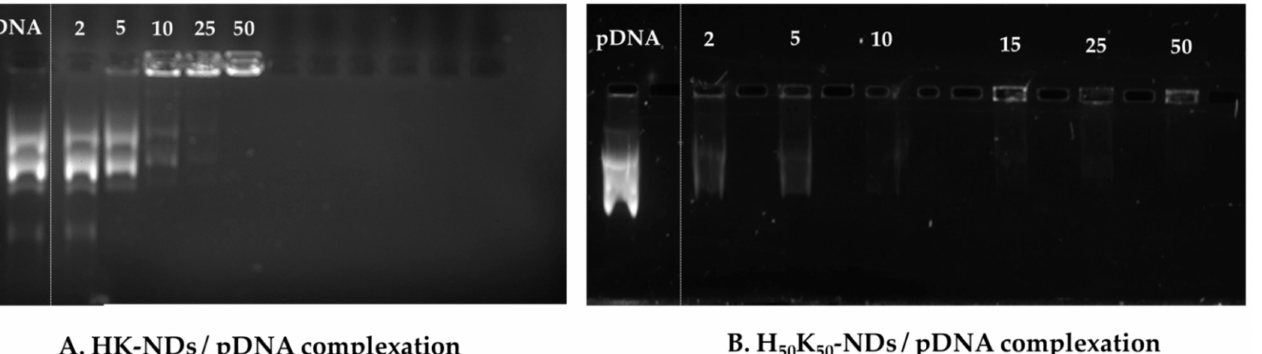
Figure 4. Binding of ( A ) HK-NDs and ( B ) H 50 K 50 -NDs with pDNA. HK-NDs binds with pDNA at minimum mass ratio of 10:1 while H 50 K 50 -NDs significantly improve gene binding starting to bind pDNA at a minimum mass ratio to 2:1. Although slight movement of band is visible at 2:1 and 5:1 mass ratios for H 50 K 50 -NDs, absence of strong bands as seen in control provides evidence of significant retardation of pDNA movement in the gel owing to strong electrostatic binding at these mass ratios (HK-NDs = lysyl-histidine-NDs; H 50 K 50 -NDs = lysine/lysyl-histidine-NDs; pDNA = plasmid deoxyribonucleic